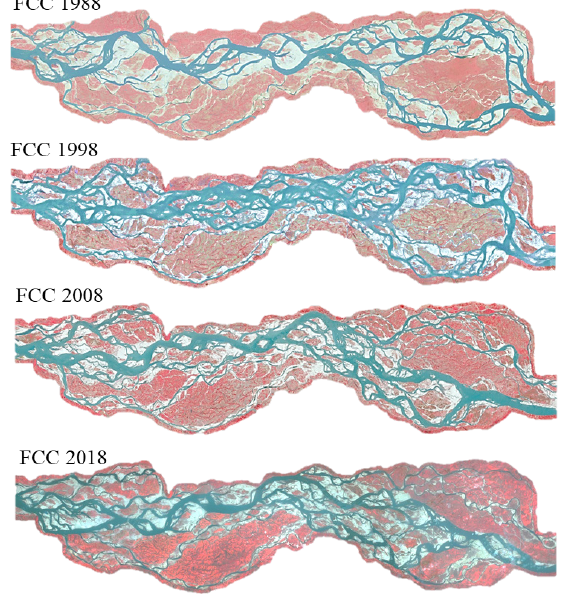
Figure 3. Decadal change of Brahmaputra river and the chars within it